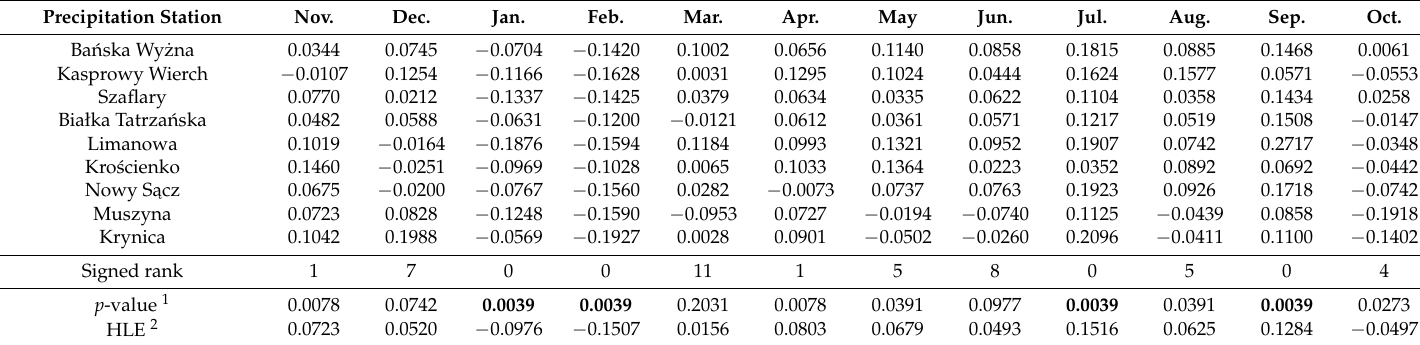
Table 4. Difference in the variability of monthly precipitation determined by the coefficient of variability between the most recent 30-year period (1986–2015) and the previous 30-year period (1956–1985). According to the Wilcoxon signed rank test with the Bonferroni correction, the median of the difference in variability of precipitation for each month is significant at p <